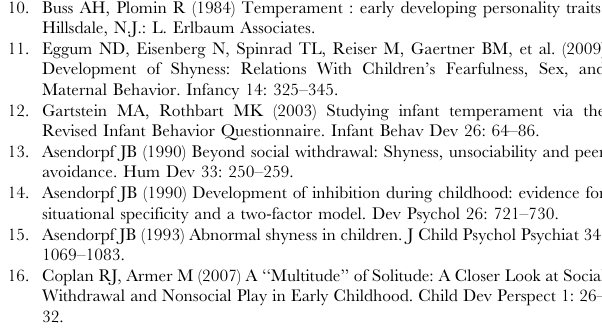
infant’s characteristics and gaze/face direction prefer- ence (related to Fig.